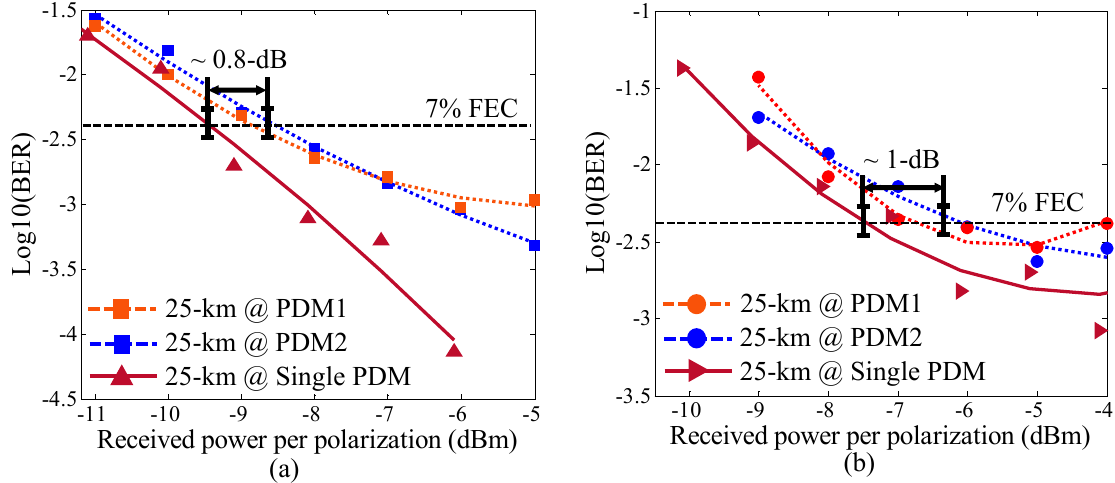
Figure 9. Twenty-five km transmission performance of the 2 × PDM-PAM4 and the single PDM-PAM4 systems. ( a ) BER at 4 × 20-Gbit/s and ( b ) 4 × 40-Gbit/s. PDM: polarization division multiplexing; FEC: forward error correction; (From [101] © 2021 OSA).